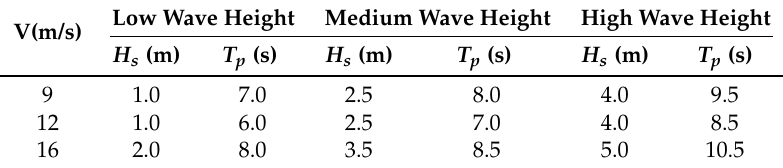
Table 11. Selected sea states for short-term response analysis.